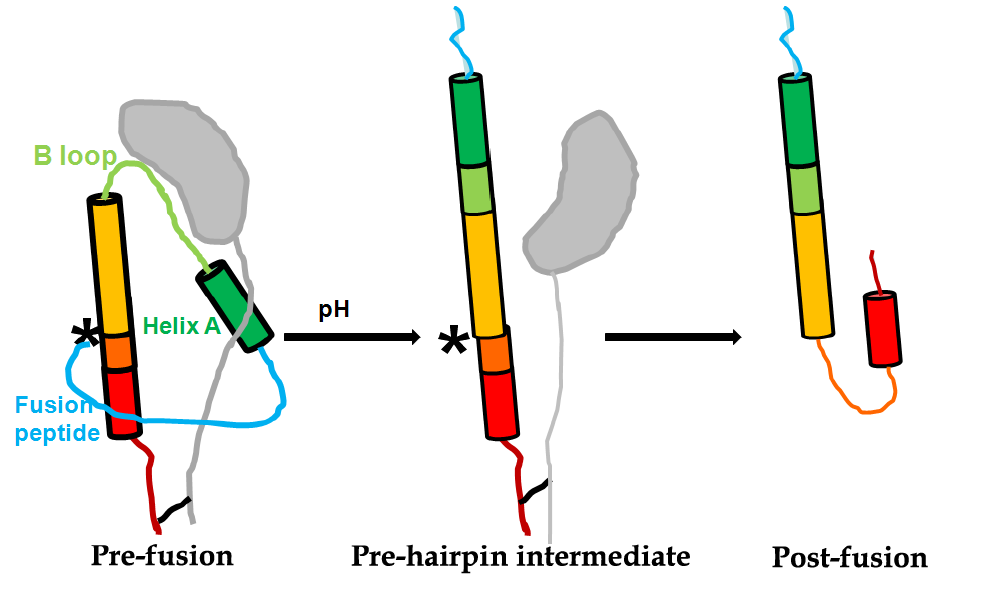
Figure 2. Scheme of pH-induced conformational change of HA2 at the pre-fusion and post-fusion states. The approximate location of HA2 residue 106 is marked with “*”. The figure was adapted from the paper published in J. Virol.